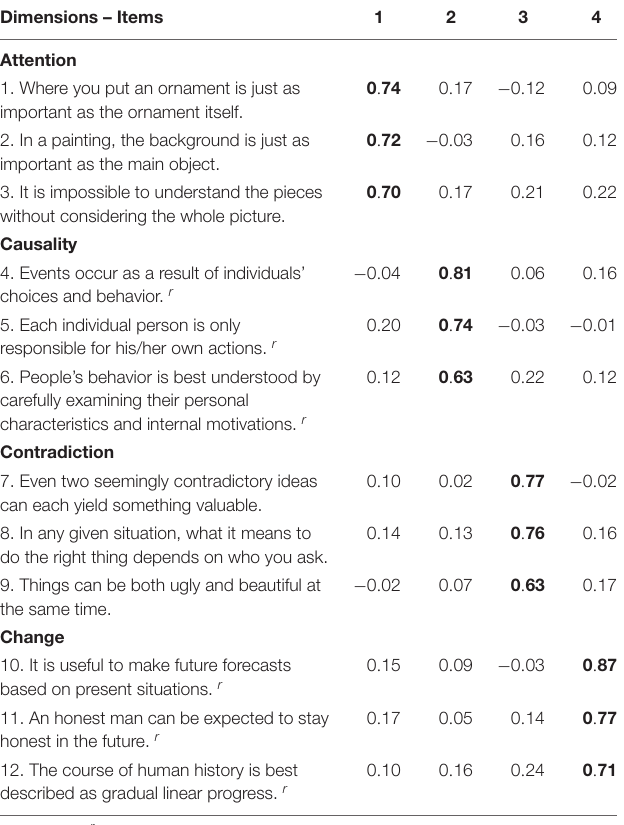
TABLE 2 | Study 2 – exploratory factor analysis of the 12-item HCS. Dimensions –